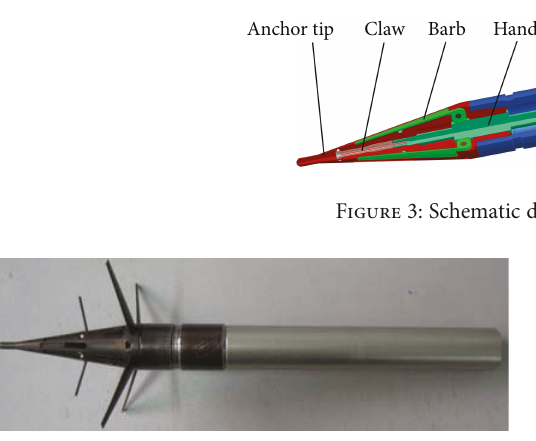
Figure 4: Schematic diagram of the penetrating unit after